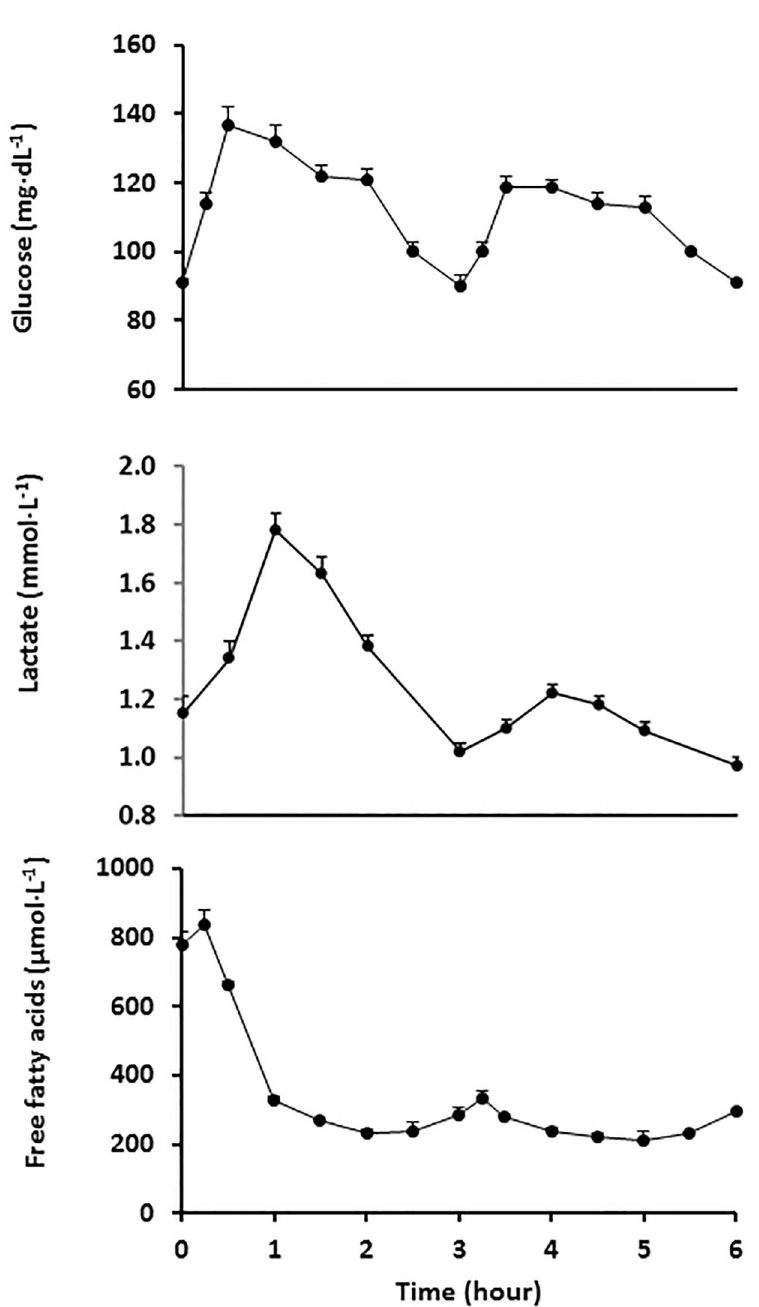
Fig 1. Circulating glucose, lactate and free-fattyacid concentrations before and after two consecutive 75-g oral glucose loads. Glucose loads were given at time 0 and 3 h. Mean ± SE.